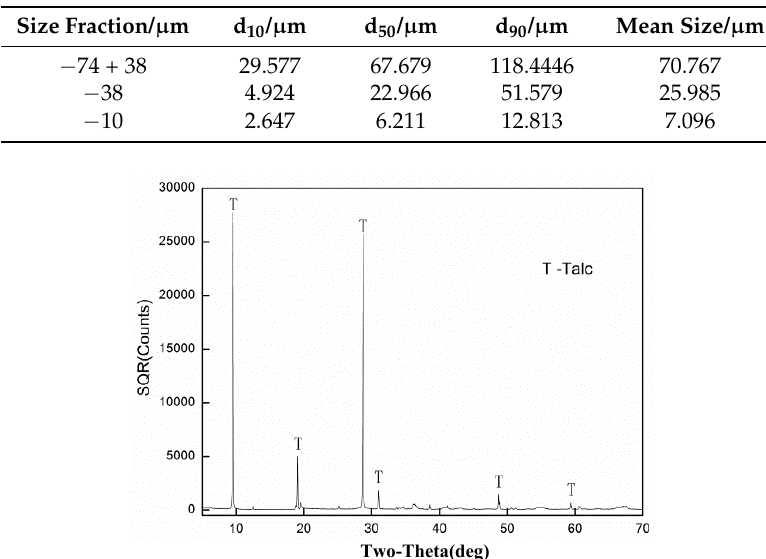
Figure 1. X-ray diffraction (XRD) spectra of pure talc for tests.